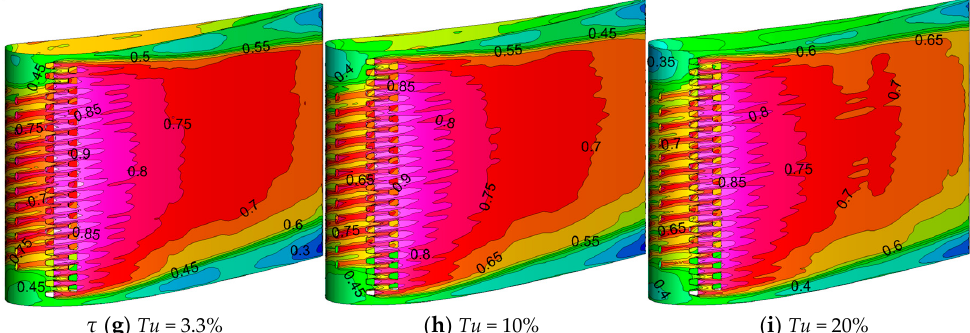
Figure 8. Contours of ( a – c ) φ ; ( d – f ) φ TBC ; ( g – i ) τ on the suction side (SS) at three Tus .